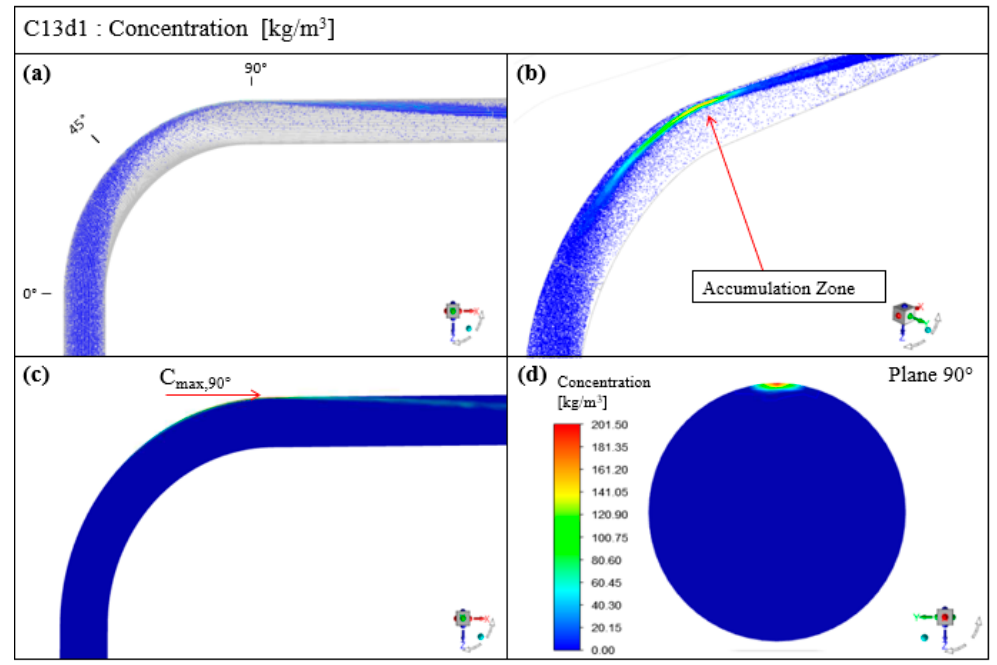
Figure A3. Results of particle concentration. Case C13d1. ( a ) Instant positioning of the X-Z plane particles ( b ) Instant positioning of the particles in 3D view ( c ) Concentration contour in the X-Z plane of the mid-section of the pipe ( d ) Concentration contour in the Z-Y plane of the maximum concentration cross section. Snapshots are taken for a statistically steady flow.